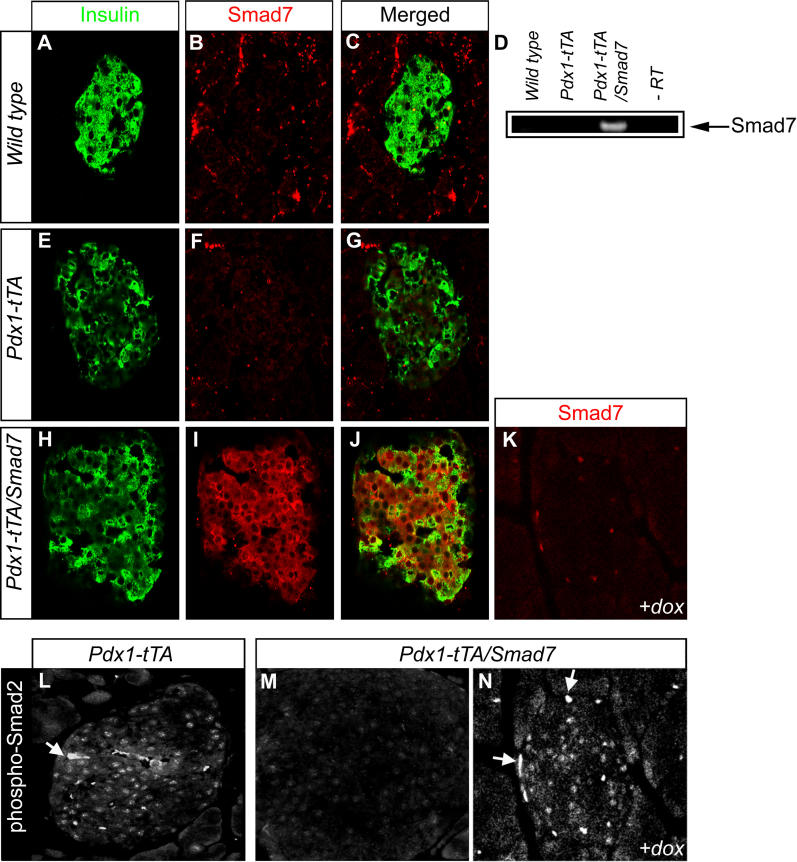
Doxycycline-Dependent Smad7 Expression and TGF-β Signaling Inhibition in
Pdx1-tTA/Smad7 Adult Islets
Data are from tissues of male mice aged 4–5 mo.(A–C and E–J) Smad7 expression by β cells in wild-type and
Pdx1-tTA controls is undetectable while immunohistochemical studies demonstrate Smad7 expression (red) in insulin-expressing β cells (green) of bitransgenic
Pdx1-tTA, TRE-Smad7 adults.
(D) RT-PCR studies of purified pancreatic islets confirm increased accumulation of
Smad7 mRNA (arrow) in the islets of bitransgenic
Pdx1-tTA/Smad7 adults.
(K) In bitransgenic animals induced to overexpress Smad7 then treated with doxycycline (
+ dox), Smad7 expression returns to wild-type levels.
(L–N) Immunohistochemical detection of phospho-Smad2 (white).(L and M) Compared to
Pdx1-tTA β cells, accumulation of phospho-Smad2 is decreased in β cells of bitransgenic
Pdx1-tTA/Smad7 adults.
(N) phospho-Smad2 expression in β cells of
Pdx1-tTA/Smad7 animals treated with doxycycline (+
dox) returns to normal. In (L, N), arrows point to autofluorescent blood cells. Original magnification of all micrographs is 63×.